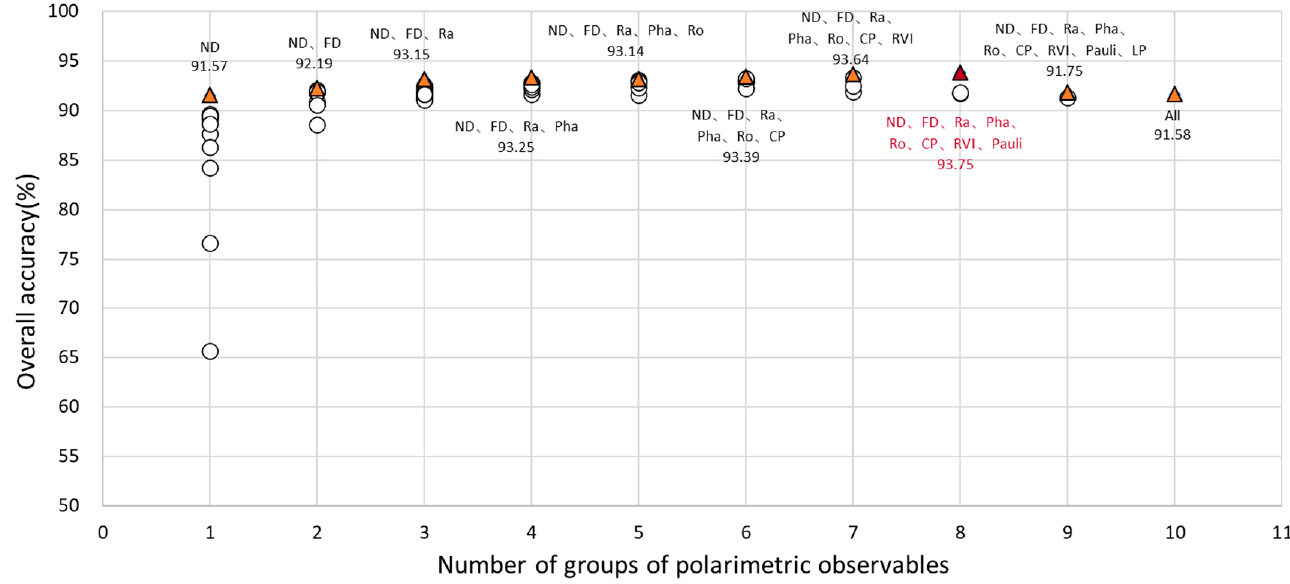
Figure 10. The RF overall accuracies for the optimal combination of polarimetric observables produced by a forward feature selection procedure using all multitemporal RADARSAT-2 images. Note that numbers in the figure denote the best accuracy in each step, and the abbreviations are explained in Table 3.